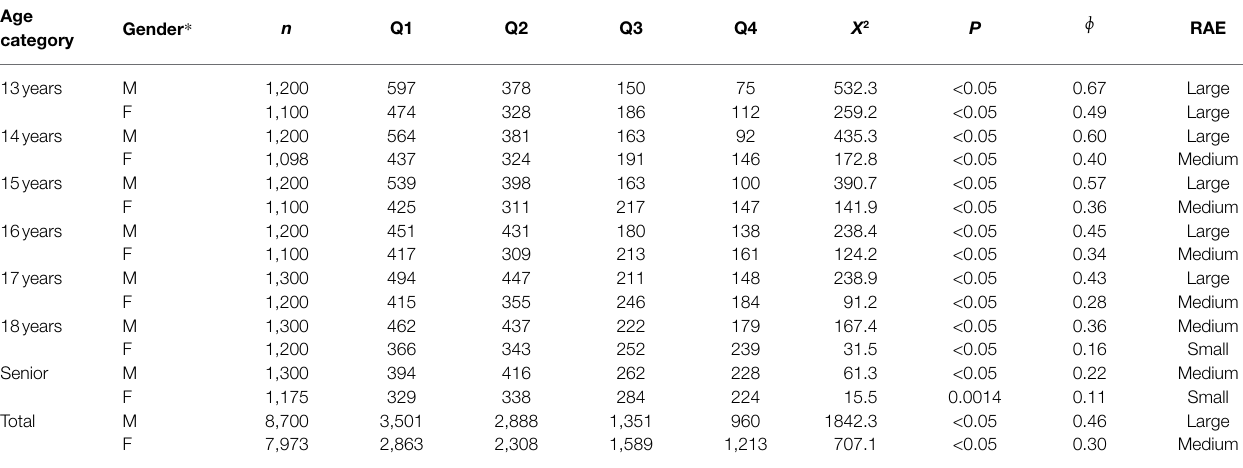
TABLE 2 | Prevalence of RAE in the explosive events among the all time best Norwegian track and field athletes, by age and gender. Age Gender category